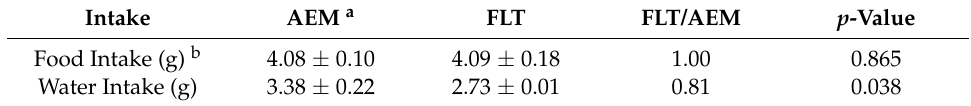
Table 2. Average food and water intake measurements for STS-135 mice and AEM controls.